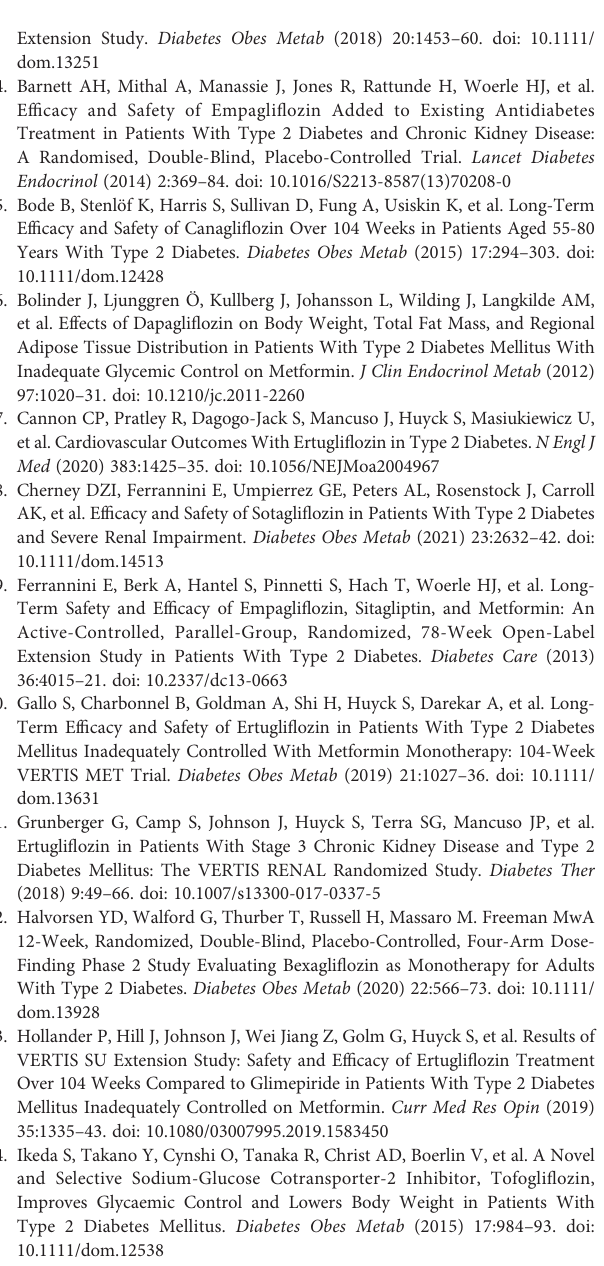
Supplementary Figure 1 | Effect of SGLT-2i on incidences of corneal disease compared with control in T2DM patients. Supplementary Figure 2 | Effect of SGLT-2i on incidences of conjuctival disease compared with control in T2DM patients. Supplementary Figure 3 | Effect of SGLT-2i on incidences of uveal disease compared with control in T2DM patients. Supplementary Figure 4 | Effect of SGLT-2i on incidences of eye haemorrhage compared with control in T2DM patients. Supplementary Figure 5 | Effect of SGLT-2i on incidences of vision problems compared with control in T2DM